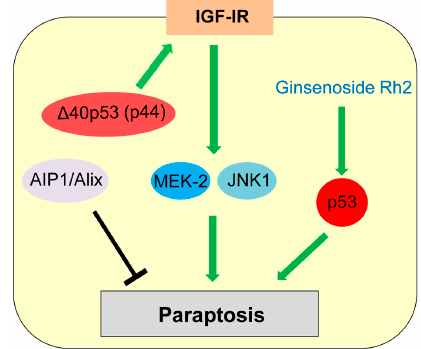
Figure 6. Role of p53 in paraptosis. Δ 40p53 (p44) increases insulin-like growth factor I receptor (IGF-IR) levels, which induces paraptosis dependent on mitogen-activated protein kinase (MAPK) member proteins (MEK-2, JNK1).